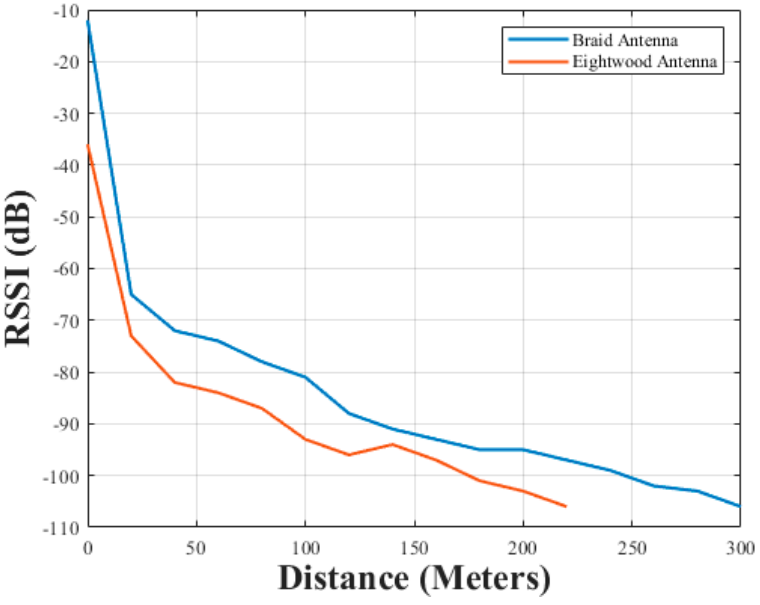
Figure 15. RSSI for antenna with respect to distance.